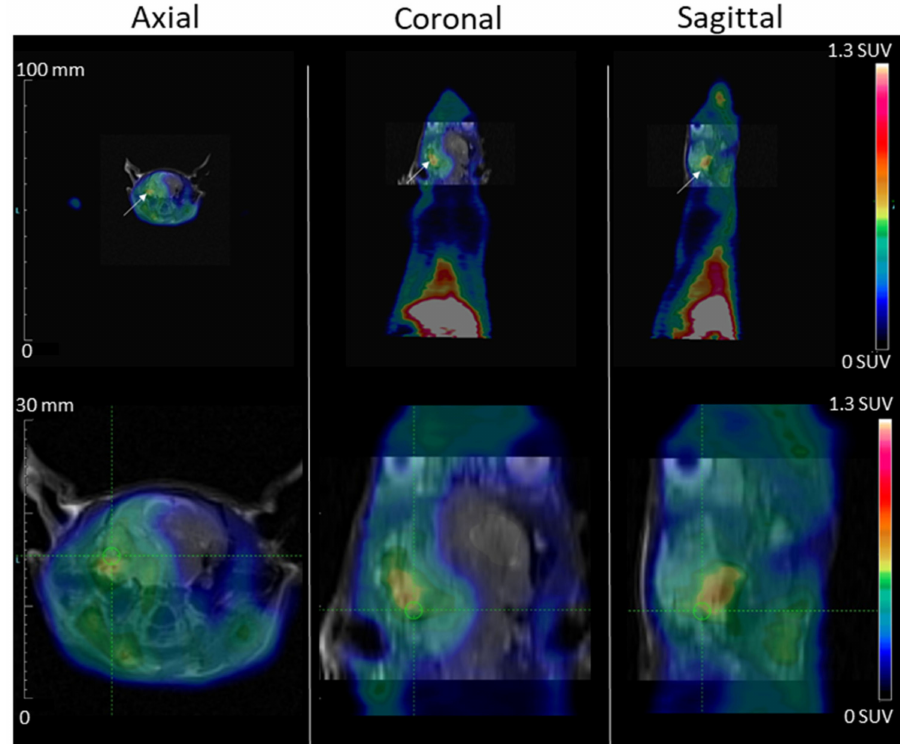
Figure 8. MDA-MB-231 tumor development in the rat brain cerebellum region after carotid injection is shown on MRI (day 52) and PET Scan (day 55)-fused images. PET images, acquired during the 2nd hour after [ 68 Ga]Ga-NODAGA-K(Cy5)DKPPR injection, showed the fixation of [ 68 Ga]Ga-NODAGA- K(Cy5)DKPPR at the anterior part of the animal (maximum field of view and brain view). The tumor is indicated with white arrows, the spatial scale is on the left, and the color scale (right) is expressed in SUV values.